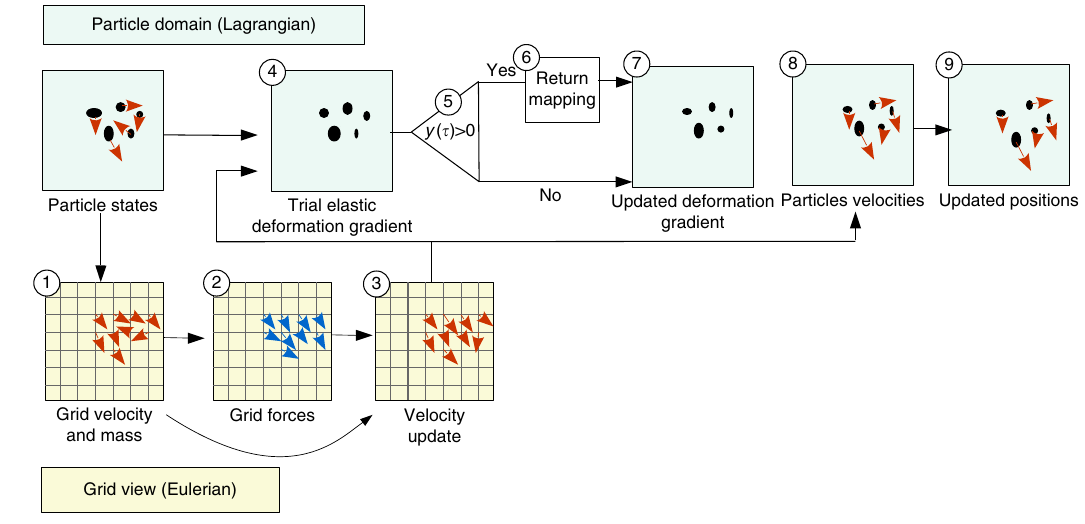
Fig. 5 Overview of the MPM